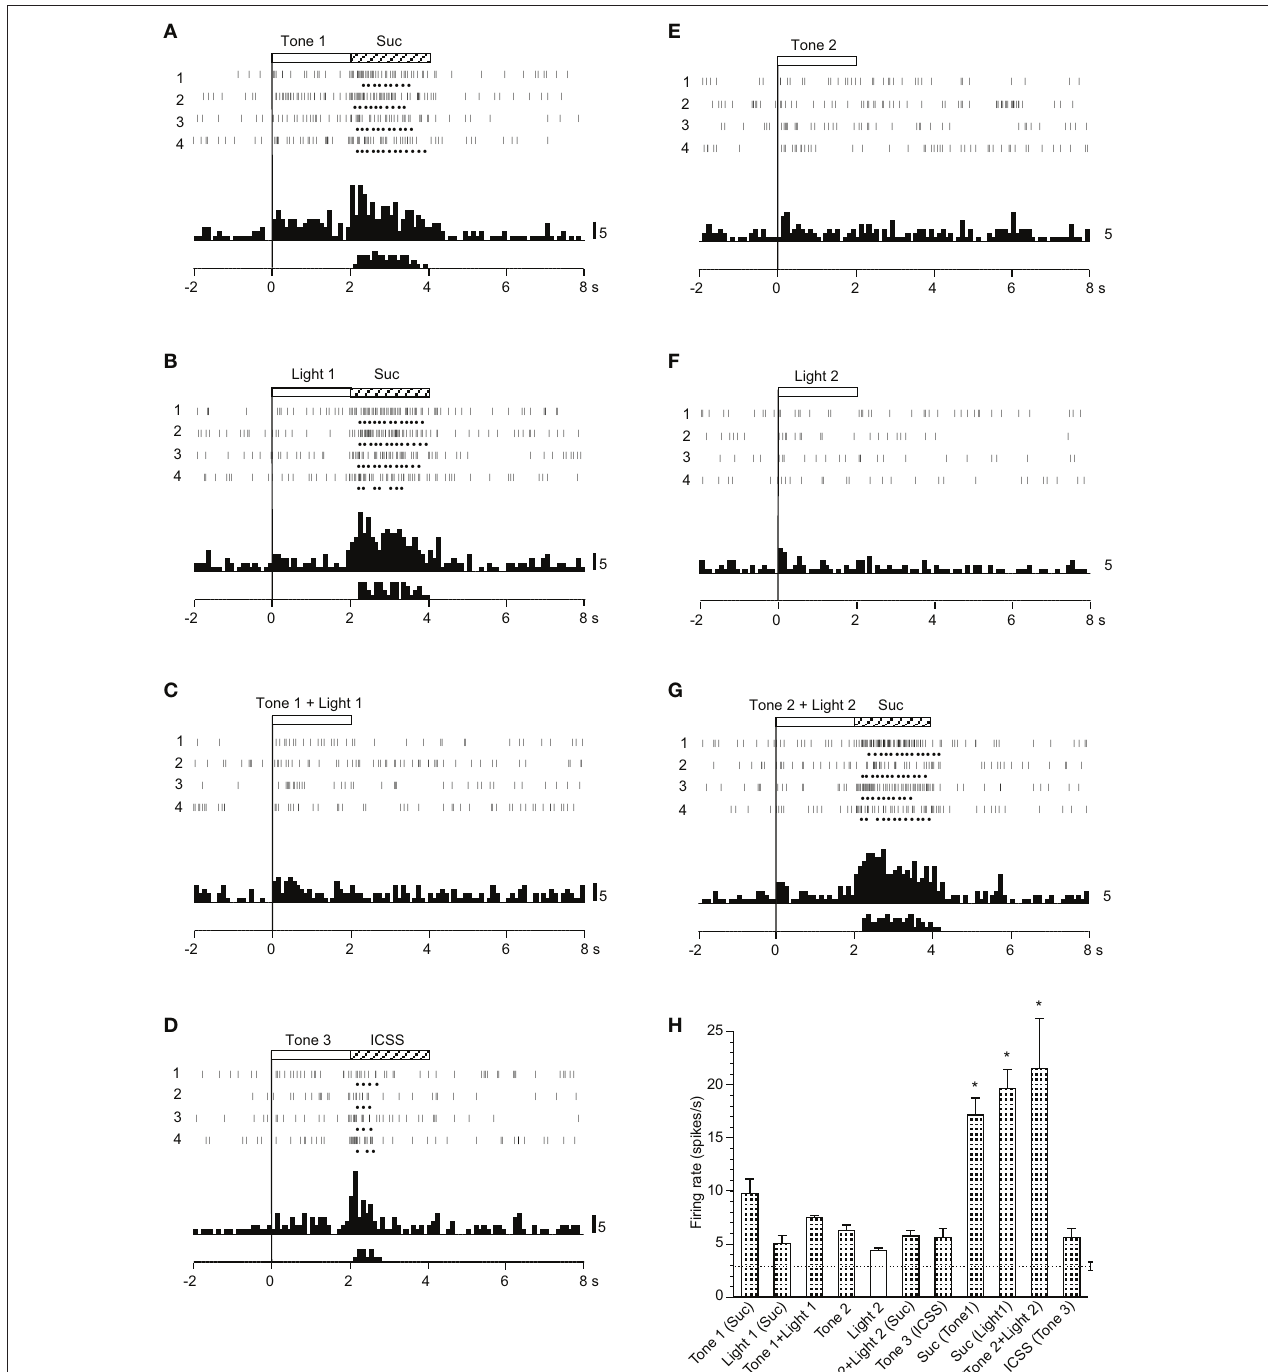
Note that neuronal activity increased during ingestion of a reward (i.e., sucrose solution or ICSS) and also during presentation of some CSs (Tone 1, Light 1, Tone 1 + Light 1, Tone 3, Tone 2, and Tone 2 + Light 2), but not Light 2. (H) Histogram of neuronal responses during presentation of each CS and ingestion of reward (mean firing rate ± SEM). *significant difference from other responses (new multiple range test after one-way ANOVA, p < 0.05). Other descriptions as in Figure